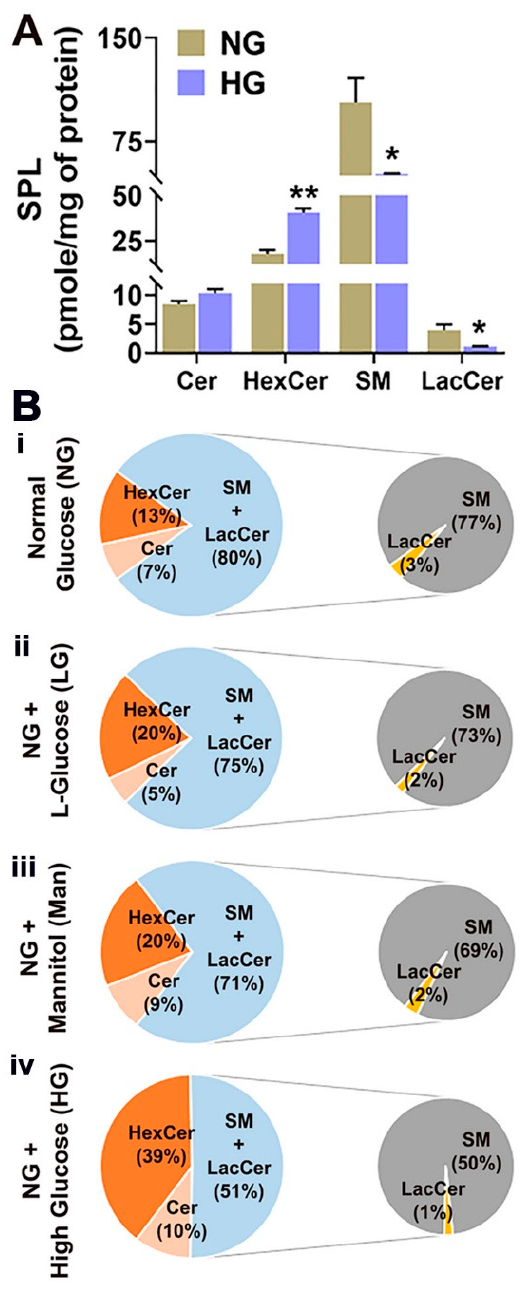
Figure 5. Analysis of major SPL classes in BV2 cells cultured in 5 mM glucose (NG), 25 mM glucose (HG), 5 mM glucose + 20 mM L-glucose (LG), and 5 mM glucose + 20 mM mannitol (Man)-containing media for 48 h. ( A ) Total concentration (pmol/mg protein) of Cer, HexCer, SM, and LacCer in NG and HG culture conditions. ( B ) Compositional analysis (mol%) of Cer, SM, HexCer, and LacCer in ( i ) NG, ( ii ) LG, ( iii ) Man, and ( iv ) HG-cultured HREC. * p < 0.05, ** p < 0.01; mean ± SEM; n = 3.